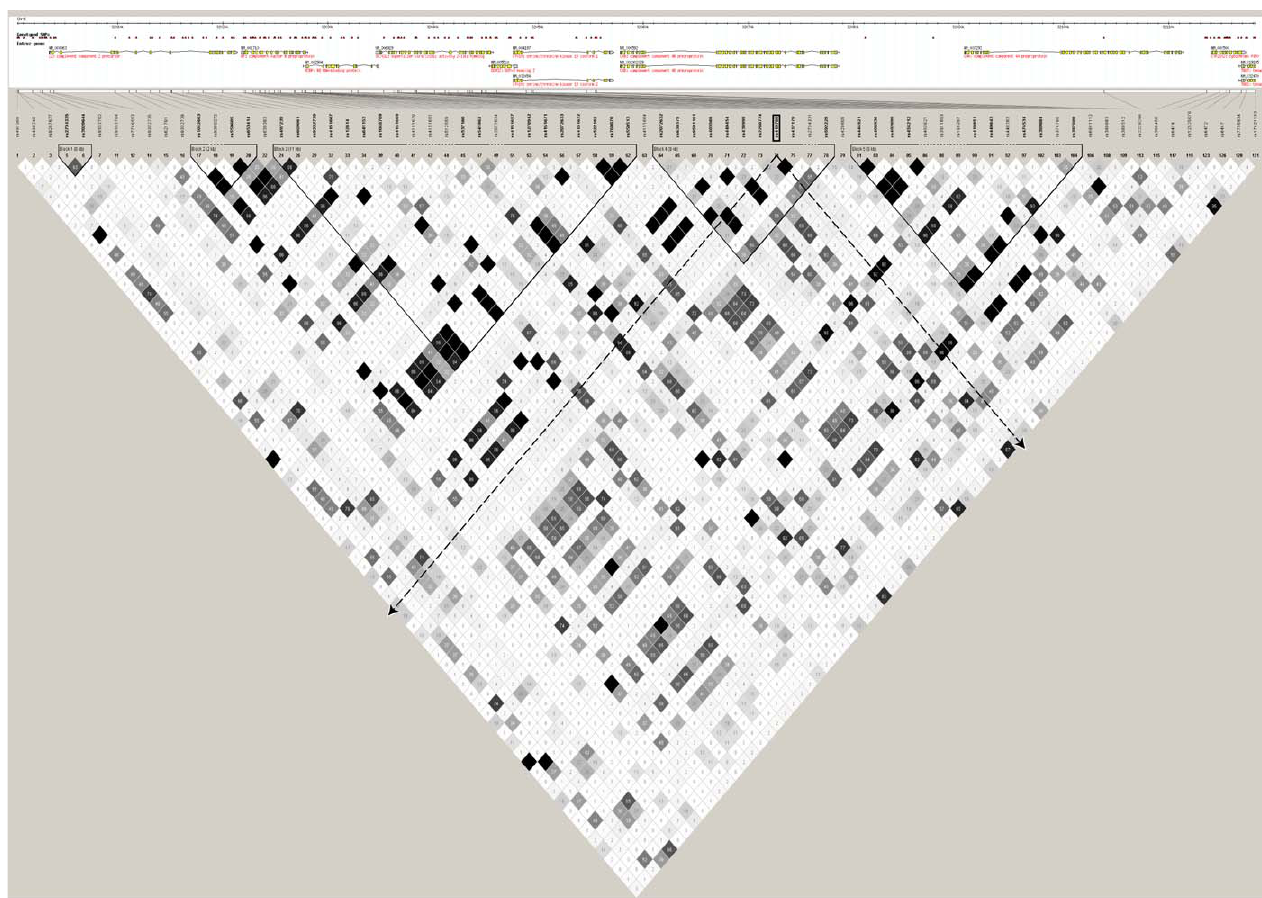
Figure 4. LD Plot of HapMap CEPH Data Centered on the Associated Class III SNP rs419788 One hundred and twenty kilobases of the MHC class III region centered on rs419788 (boxed) in HapMap CEPH families is illustrated. The grey ticks indicate SNP location with gene location shown above and rs numbers below. The triangular units designate haplotype blocks. The degree of correlation (LD) between pairs of markers is indicated by the correlation coefficient r 2 (where r 2 ¼ 0 ¼ no correlation, white; 0 , r 2 , 1, shades of grey; r 2 ¼ 1 ¼ complete correlation, black). The dashed arrows depict LD between rs419788 and surrounding SNPs. Significant LD ( r 2 . 0.8) is observed with rs419788 and three further SNPs within SKIV2L , two SNPs in STK19 , and one SNP in CFB . doi:10.1371/journal.pgen.0030192.g004 PLoS Genetics |